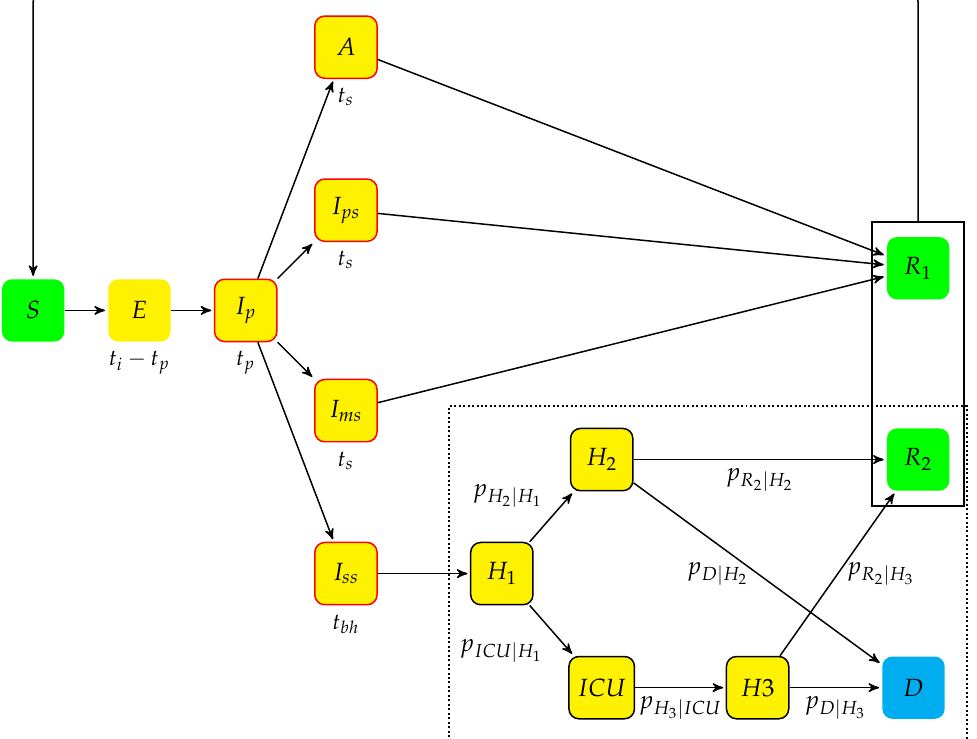
Figure 1. The states and their connections in the model. The left-hand part of the model represents the disease spreading with the average sojourn time beneath each compartment. The right-hand part of the model (bottom-right dotted frame) represents the hospitalized cases and their outcomes. It is composed of states H 1 , H 2 , H 3 , ICU , R 2 , and D . Each arrow is labeled with the individual daily transition probability between two